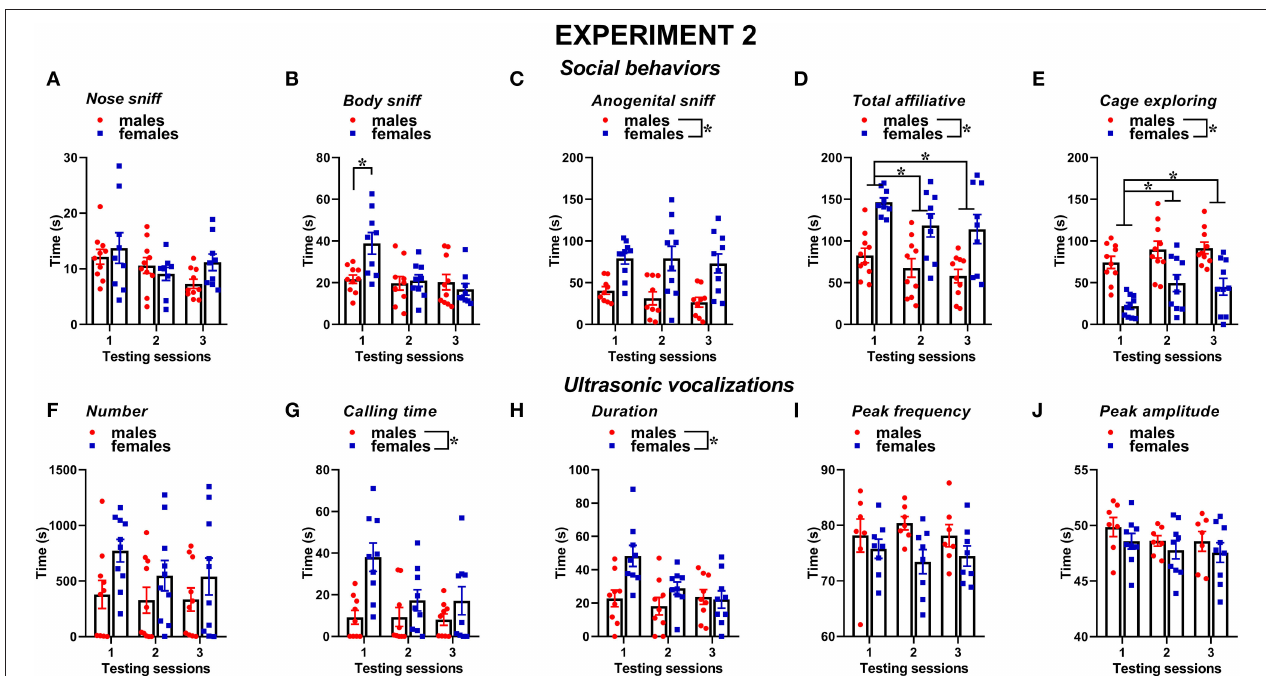
FIGURE 6 | Sex differences in social behaviors and USVs in experiment 2 (different pre-testing isolation). (A–E) Social behaviors and (F–J) USVs of the male and female experimental B6 subjects were assessed by analysis of the video recordings (Observer, Noldus) and spectrograms (Avisoft SASLab Pro), respectively. The B6 female mice were isolated for 3 days in the testing cage before each social encounter as in experiment 1, while the male mice were isolated for only 10min pre-testing, as in most commonly used procedures. As in experiment 1, social behavior and USVs were analyzed during 3 testing sessions of 3min each (inter-session interval: 7–10 days) using an adult female CD1 as stimulus. Data are mean ± SEM. N = 10 before exclusion of statistical outliers by Grubb’s test for small samples.* p < 0.05. Sex differences are reported as * in each graph legend when a significant main effect of sex was detected in the absence of any interaction with testing